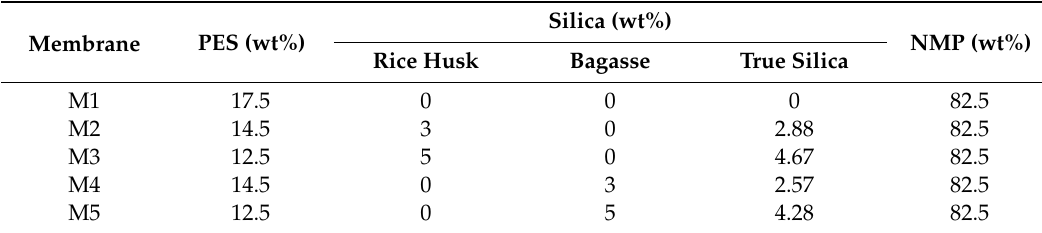
Table 2. Composition of casting